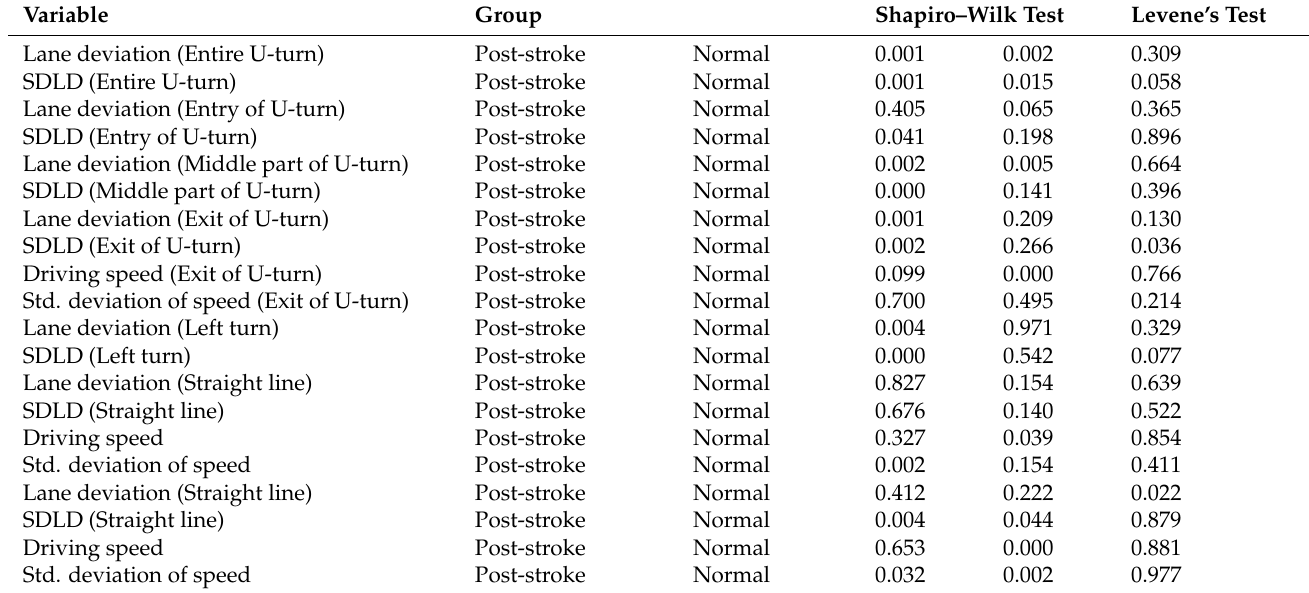
Table A1. Normality and homoscedasticity